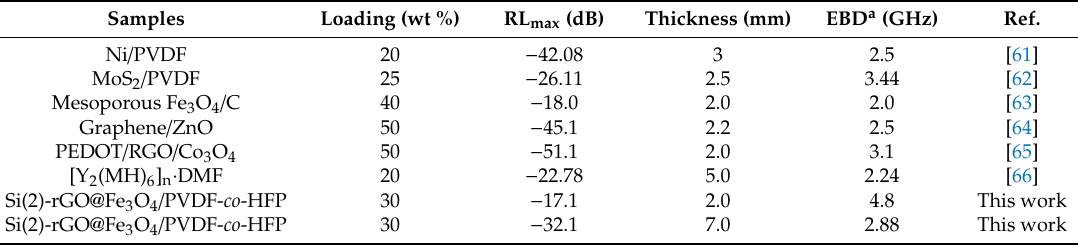
Table 1. Comparison of microwave absorption performance of similar composite in the range